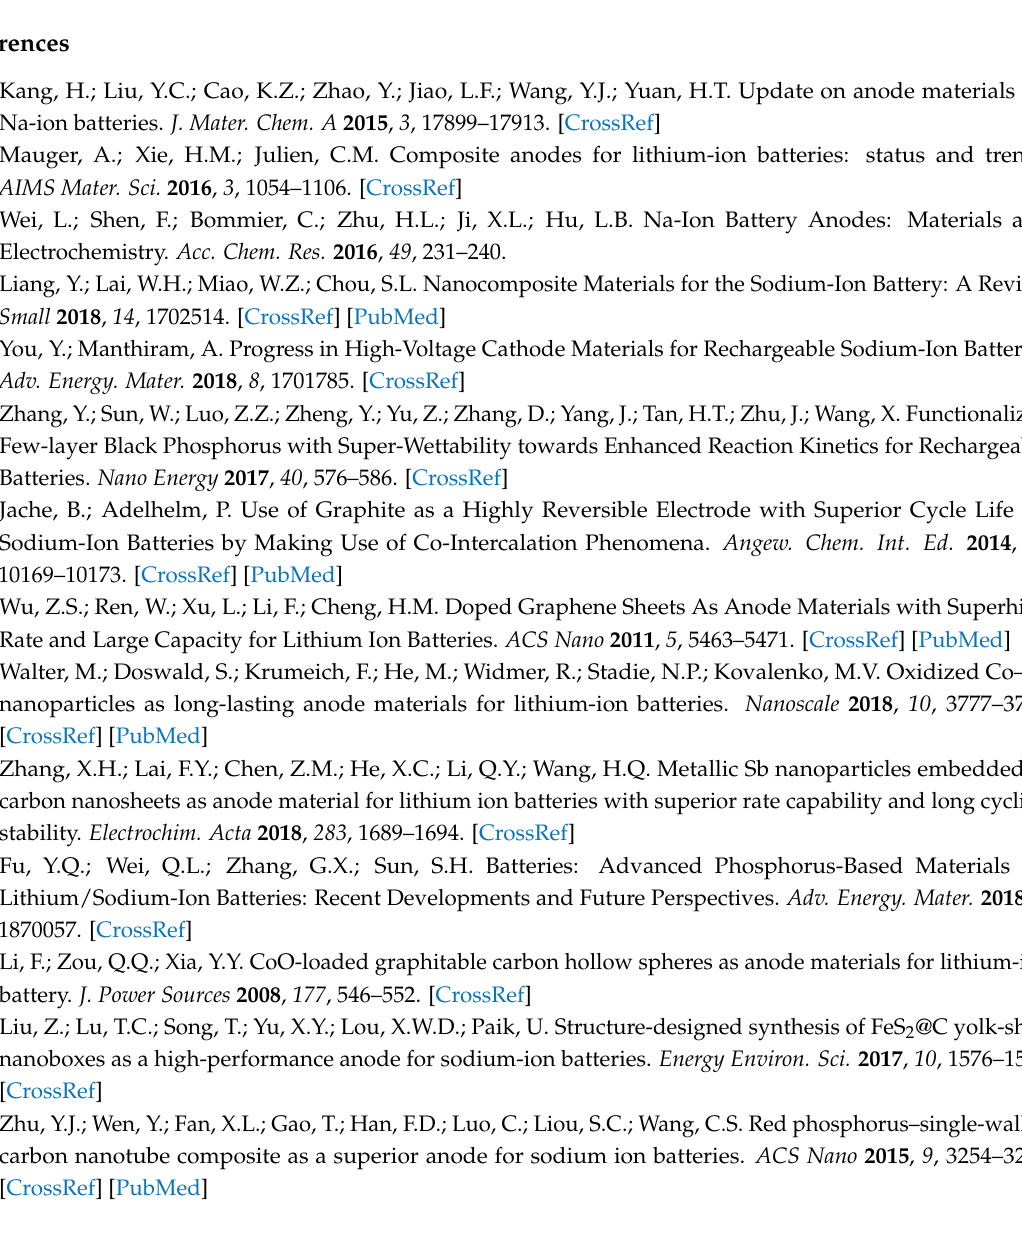
Figure S1: Cycling performance of the pure SWCNT electrode for SIBs at a current density of 100 mA g − 1